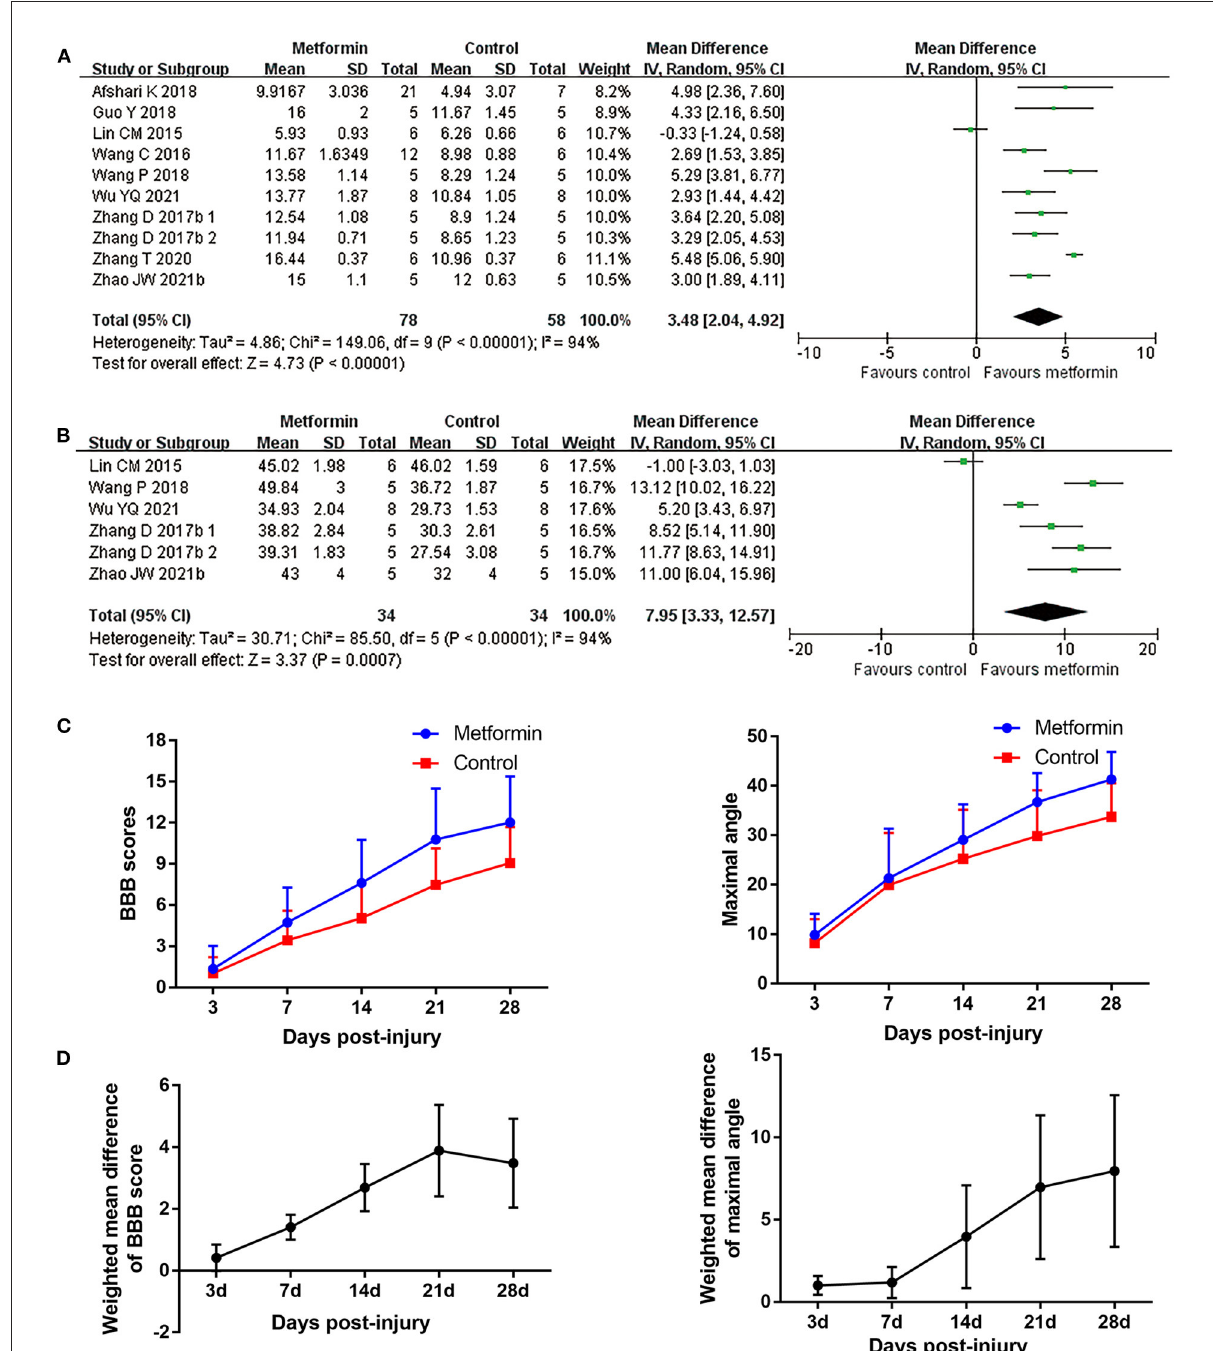
FIGURE2 Overall analyses of the effects of metformin on dynamic changes of neurological function. (A,B) BBB scale, inclined plane test meta-analysis at 28th day after SCI. (C) The BBB scores and inclined plane scores in each group over time. (D) The WMDs of BBB score between metformin and control groups from 3rd to 28th day after